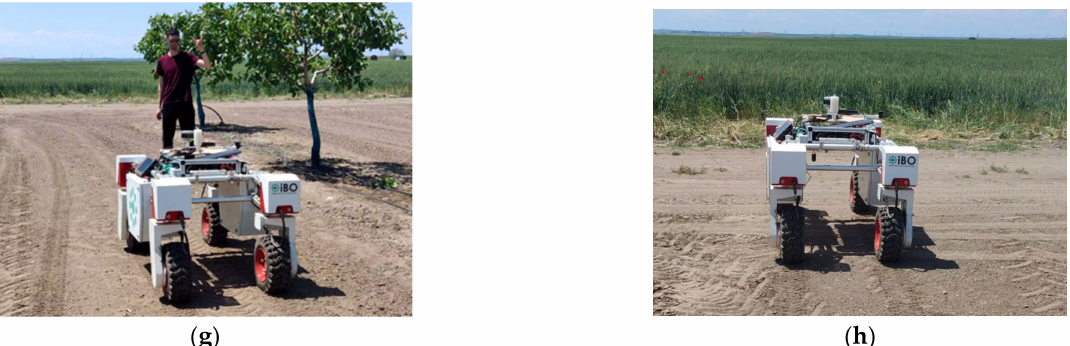
Figure 9. Snapshots from experimental demonstration session in an orchard depicting ( a ) the lock- ing onto of the first person by the UGV, as well as the UGV ( b ) following the locked participant, ( c ) stopping, and ( d ) unlocking this participant. Next, the UGV ( e ) locked onto the second participant, ( f ) followed him, ( g ) was ordered to go to the target location, and ( h ) reached this